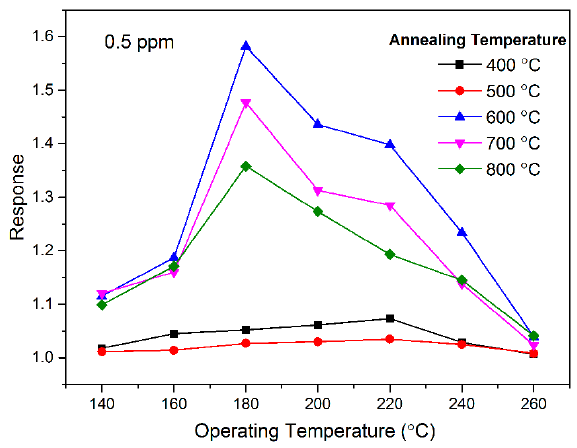
Figure 3. The response characteristics of the SnO 2 thick-films as a function of the operating temperature. Table 1. Maximum acetone sensing response and optimum operating temperature of SnO 2 sensors.